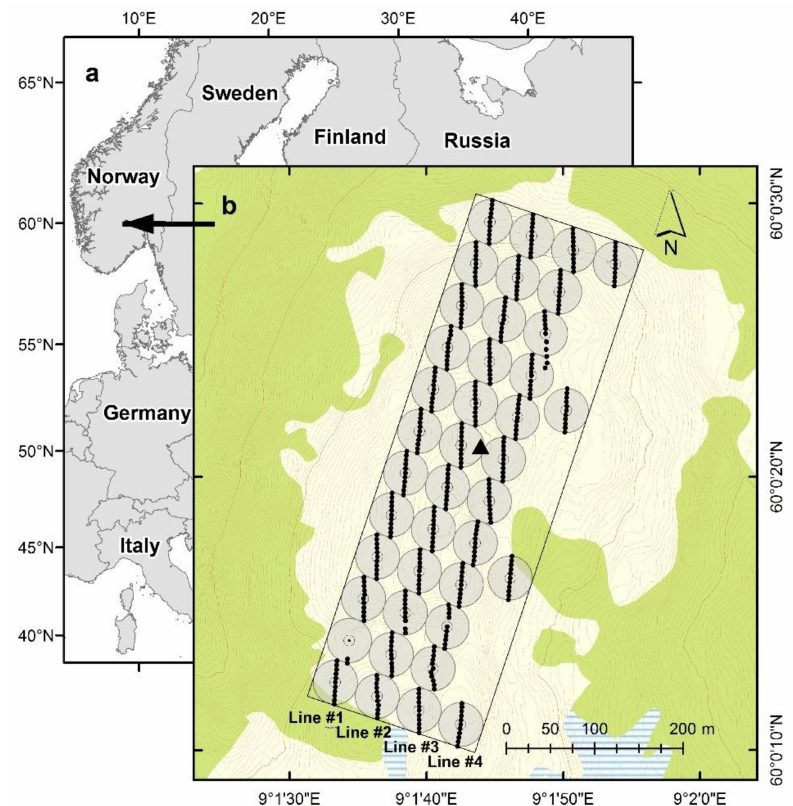
Figure 1. ( a ) Location of the study area and ( b ) design of the trial. Black dots are the ground reference points ( n = 426); small circles indicate the locations of the point-centered quarter sampling points (black dots; n = 40), which were centers of the 25 m radius plots (gray circles) arranged along four sample lines; green is defined as forest according to the official N50 topographic map series; light yellow is above the tree line; the black triangle is the reference point (base